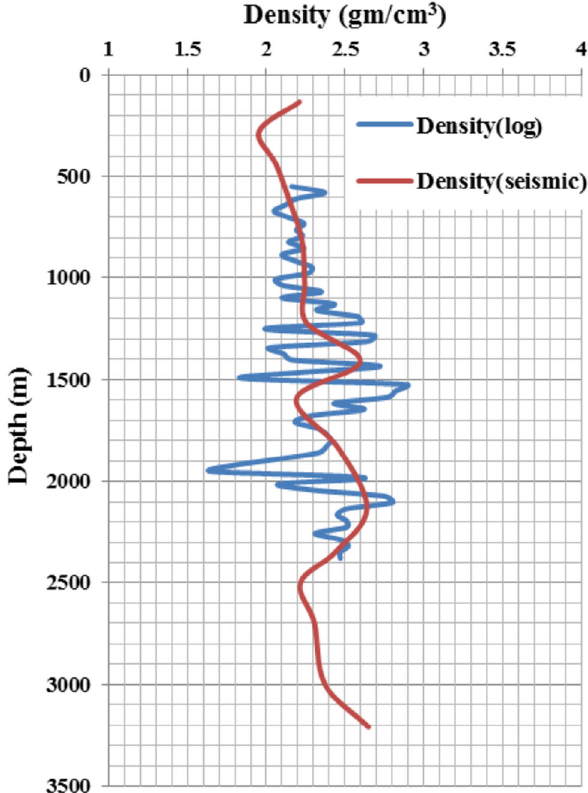
Fig. 6 Interval transit time for CDP 120 inline 10235